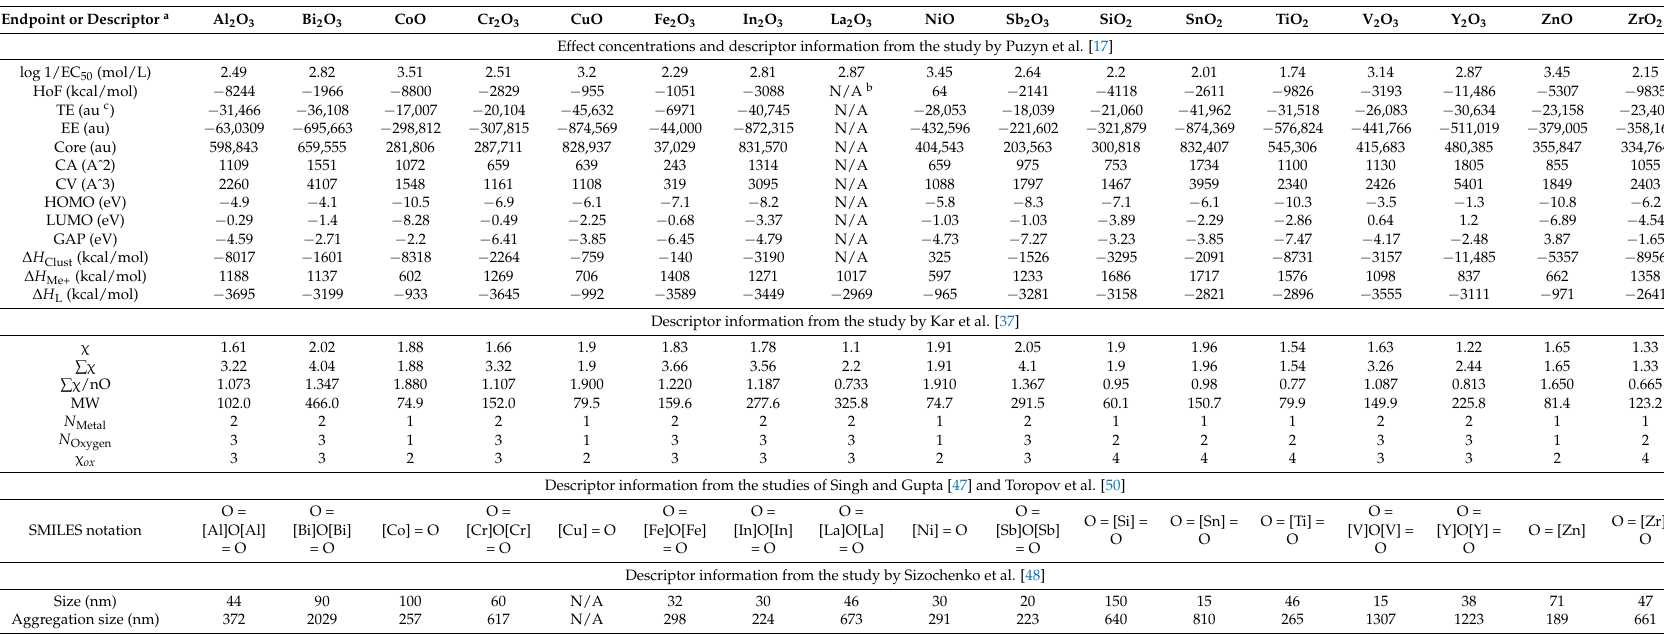
Table 5. Toxic data to Escherichia coli ( E. coli ) reported by Puzyn et al. [17] and Pathakoti et al. [46] along with corresponding ENM